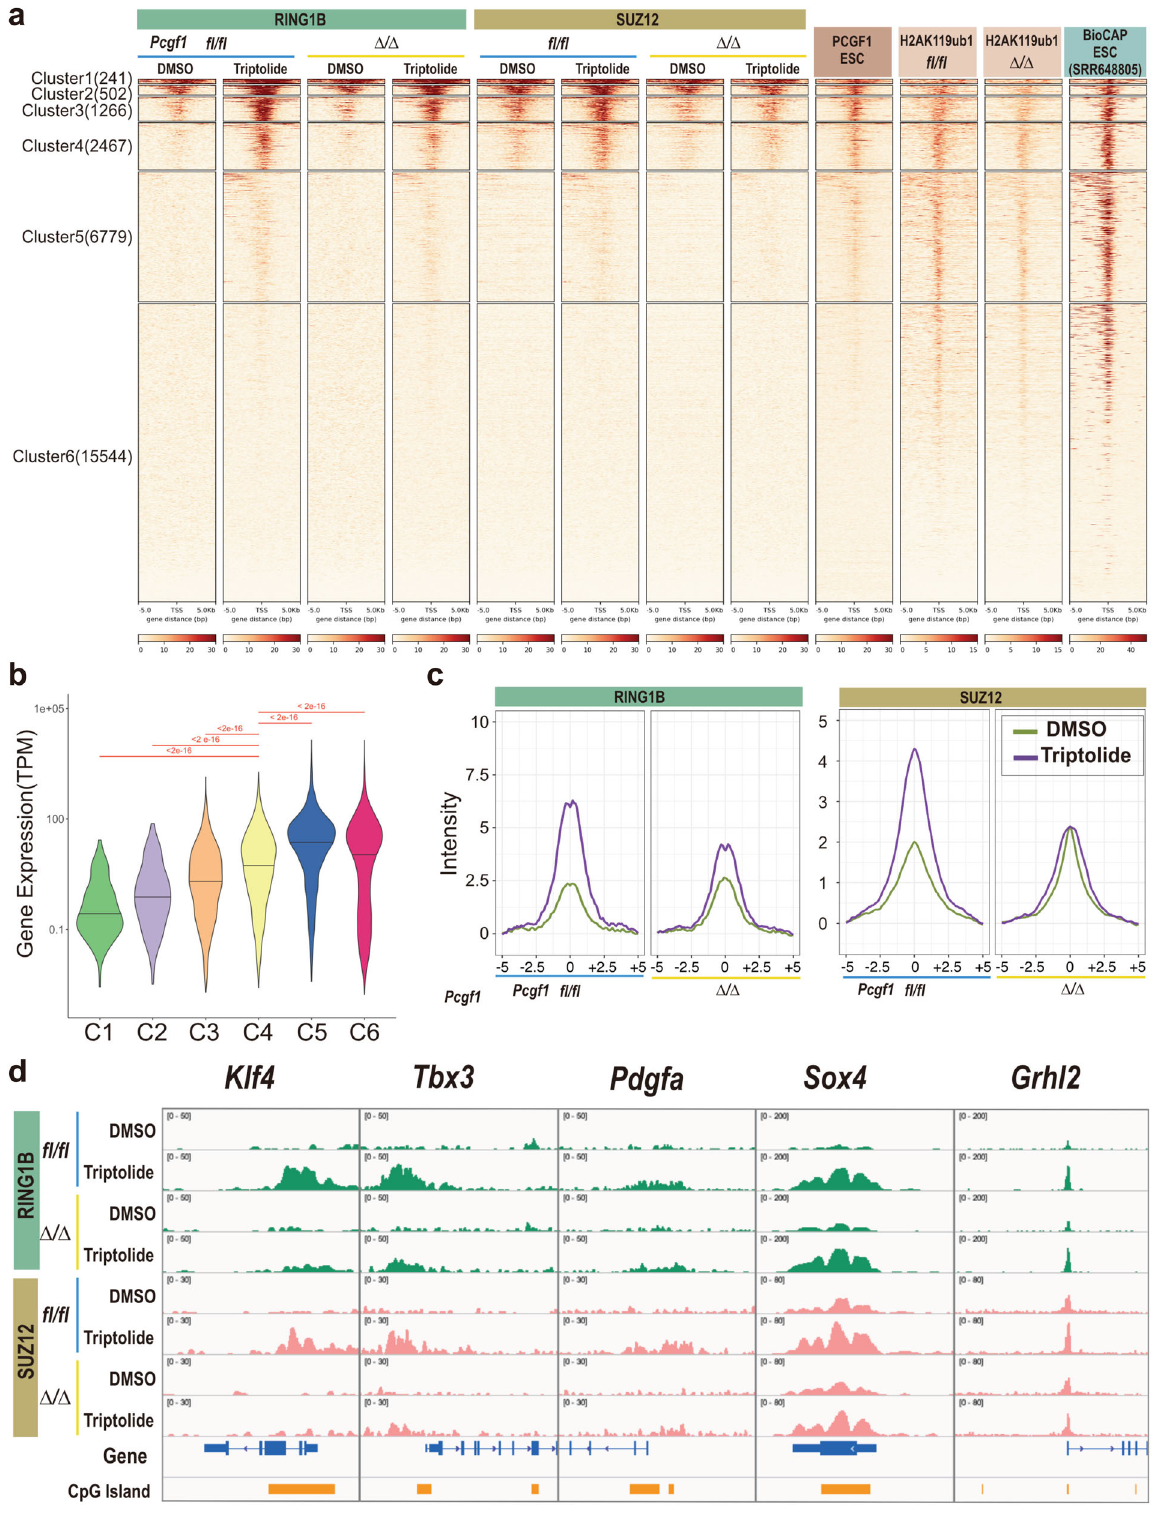
propose a role of PCGF1-PRC1 for prospective downregulation to transcriptionally active target genes associated with CGIs. Con- sistent with this role of PCGF1 in development, Pcgf1 -KO exhibits disruption of differentiation abilities in ESCs, and a variety of other morphological defects, leading to early gestational lethality